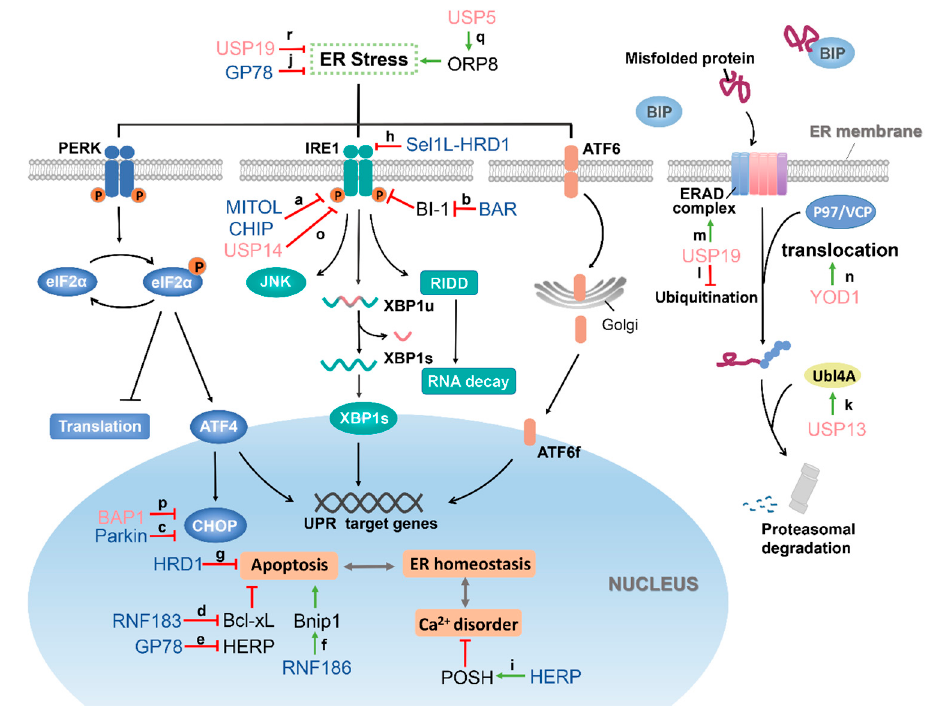
Figure 2. The functional roles of E3 ubiquitin ligases (blue) and DUBs (pink) in the ER stress and ERAD signaling pathway. Once the unfolded protein is overloaded, the three signaling sensor proteins PERK (blue), IRE1 (green), and ATF6 (orange) that reside on the ER membrane are activated, and the activated PERK phosphorylates the eukaryotic translation initiation factor 2 α (eIF2 α ), inhibiting global translation, reducing ER protein-load while also increasing transcription factor ATF4. Activated IRE1 triggers XBP1 mRNA splicing to initiate the synthesis of the transcription factor XBP1. It also enhances mRNA degradation, reduces the total protein content of the ER, and activates JNK and other cellular pathways. ATF6 is translocated into Golgi in response to ER stress and is cleaved to release the transcription factor ATF6f. These transcription factors, in turn, initiate a cascade of signals that relieve ER stress and restore homeostasis or induce cell death pathways. At the same time, the misfolded protein is reverse-transported to the cytoplasm with the assistance of the ERAD complex and the P97/VCP (valosin-containing protein) complex to complete the proteasome degradation. ( a ) The ubiquitination of IRE1 α by mitochondrial ubiquitin ligase (MITOL) and carboxy-terminus of Hsc70-interacting protein (CHIP) inhibits its kinase activity, allowing for the suppression of ER stress. ( b ) BI-1 can interact with IRE1 α and regulate its endonuclease activity. However, BI-1 is degraded by ubiquitination by bifunctional apoptosis regulator (BAR), leading to the release of the inhibitory effect of IRE1 α , thereby promoting ER stress. ( c ) CHOP is violently induced when ER stress occurs, and overexpression of CHOP can lead to cell apoptosis. CHOP is ubiquitinated by Parkin to promote its degradation, which prevents ER stress-induced cell death. ( d ) Bcl-xL is an antiapoptotic protein and belongs to one of the Bcl-2 family mem- bers. RNF183 protein increases during ER stress occurs and ubiquitinates Bcl-xL to promote its degradation, leading to increased ER stress-induced apoptosis. ( e ) HERP (homocysteine-induced endoplasmic reticulum protein) is a negative regulator of ER stress, and it can protect cells from apoptosis mediated by ER stress. GP78 can interact with HERP, causing HERP to be ubiquitinated and degraded, thereby starting the process of ER stress recovery. ( f ) Bnip1 is a proapoptotic protein. RNF186 overexpression promotes Bnip1 ubiquitination and transfer to mitochondria but does not affect its protein level. Poly-ubiquitinated BNip1 amplifies RNF186-induced apoptosis signaling of ER stress. ( g ) HRD1 expression is up- regulated by ER stress, and HRD1 rescues cells from ER stress-induced apoptosis. ( h ) Sel1L-HRD1 protein complex can recognize, ubiquitinate IRE1 α , and mediate its degradation, restraining IRE1 α signaling and reduces IRE1 α -associated inflammation. ( i ) HERP also plays a vital role in maintaining calcium homeostasis during ER stress. POSH ubiquitinates HERP and promotes the redistribution of HERP from TGN to the ER, thereby regulating calcium homeostasis by increas- ing the level of HERP in the ER. ( j ) GP78 protects against ER stress in zebrafish liver, but the specific protective mechanism is not yet clear. ( k ) USP13 stabilizes UBL4A by deubiquitination, which is a functional component of ERAD, thus allowing proteasome degradation to proceed normally. ( l ) USP19 blocks the degradation of TCRa and other ERAD substrates through deubiquitination. ( m ) In addition, USP19 can deubiquitinate HRD1, which plays a key role in ERAD, and USP19 promotes ERAD by stabilizing HRD1. ( n ) YOD1 eliminates the Ub chains attached to substrates such as RI332 through deubiquitination and promotes the reverse translocation of substrates from the ER to the cytoplasm. ( o ) USP14 binds to IRE1 and inhibits its phosphorylation, thereby blocking IRE1-mediated cell death. ( p ) BAP1 directly binds to promoters of CHOP and inhibits the unfolded protein response (UPR) and associated apoptotic pathways by reducing its transcrip- tion. ( q ) ORP8 is a lipid transfer protein anchored to the ER, which can be deubiquitinated by USP5, causing disturbance